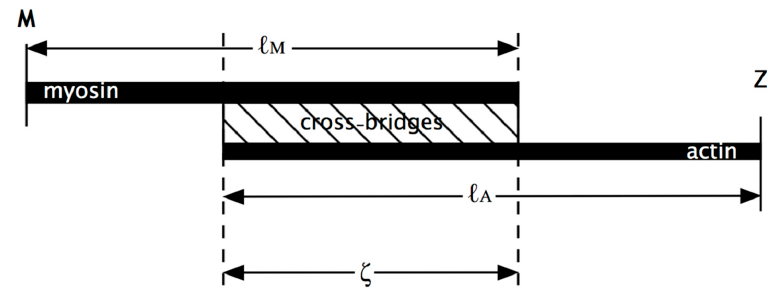
Figure A2. Diagram of the simplified model of the sarcomere used to derive Equation (A1) in the appendix. (cid:96) A and (cid:96) M represent the thin and thick filament lengths respectively. ζ is the overlap